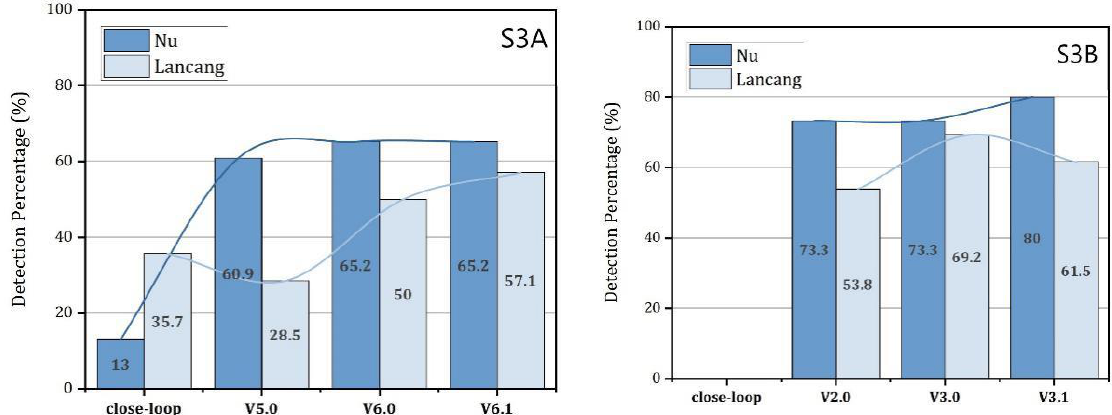
Figure 8. Comparison of the detection rates in the Lancang and Nu Rivers at different stages. The left panel of the figure displays the performance of Sentinel-3A (S3A), while the right panel shows that of Sentinel-3B (S3B). The bars and trend lines represent the satellite ’ s detection rate in the region and the trend line of the detection rate, respectively. The Nu River is denoted by the blue color, while the Lancang River is represented by the greenish-gray color.